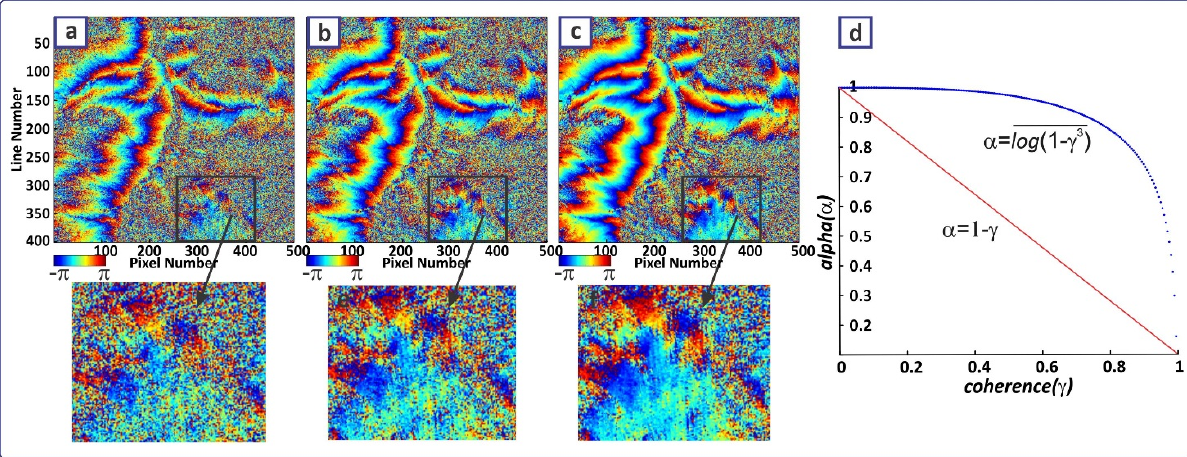
Figure 17. Comparison between standard (used in StaMPS method) and Modified Goldstein filter for a close-up view of the black rectangle in Figure 6. ( a ) Filtered wrapped phase interferogram for standard Goldstein with α ~0.6; ( b ) Modified Goldstein filter from [38] with α = 1 − γ ( γ : coherence); ( c ) Our modified Goldstein filter with α = log (cid:4666)1 (cid:3398) (cid:2011) (cid:2871) (cid:3364)(cid:3364)(cid:3364)(cid:3364)(cid:3364)(cid:3364)(cid:3364)(cid:3364)(cid:3364)(cid:3364)(cid:3364)(cid:3364)(cid:3364)(cid:3364) (cid:4667) ; ( d ) Variation of the α parameter with respect to coherence ( γ ) value. The red refers to modified Goldstein filtering in [38] while blue refers to our modified filtering.